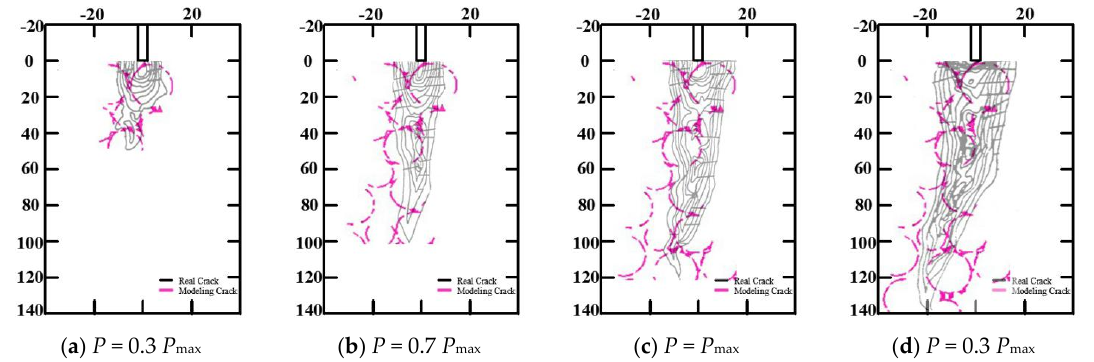
Figure 5. Evolution process of the WS specimen fracture process zone.